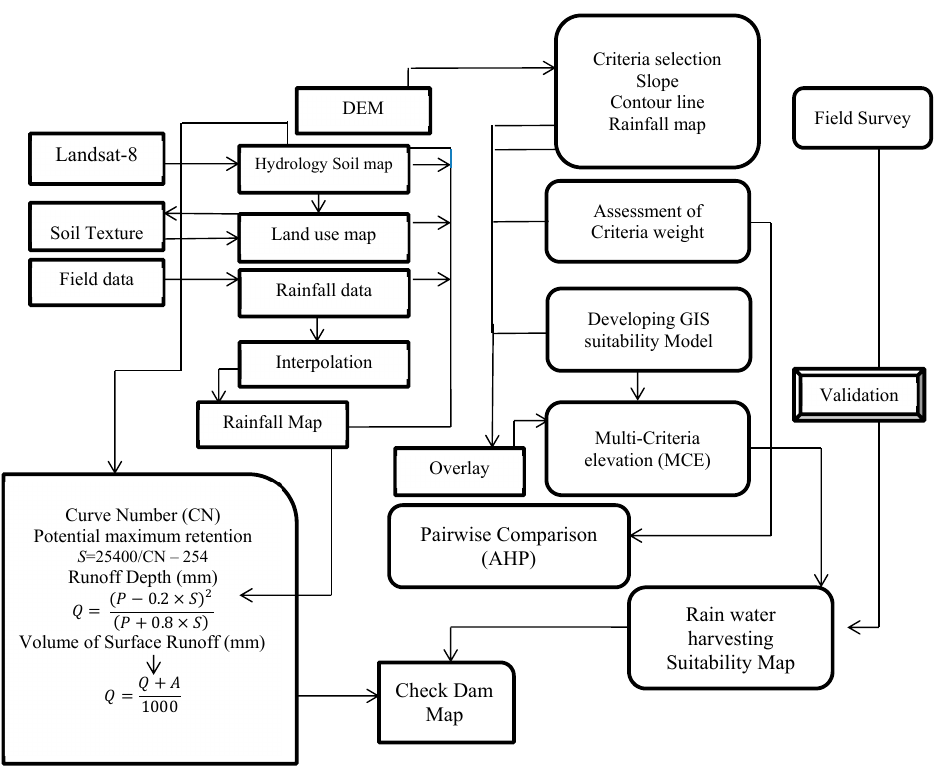
Figure 3. Flowchart for generation rain water harvesting mapping, Q v is the volume of surface runoff (mm 3 ), Q is the runoff depth (mm) and A is the basin area (km 2 ).